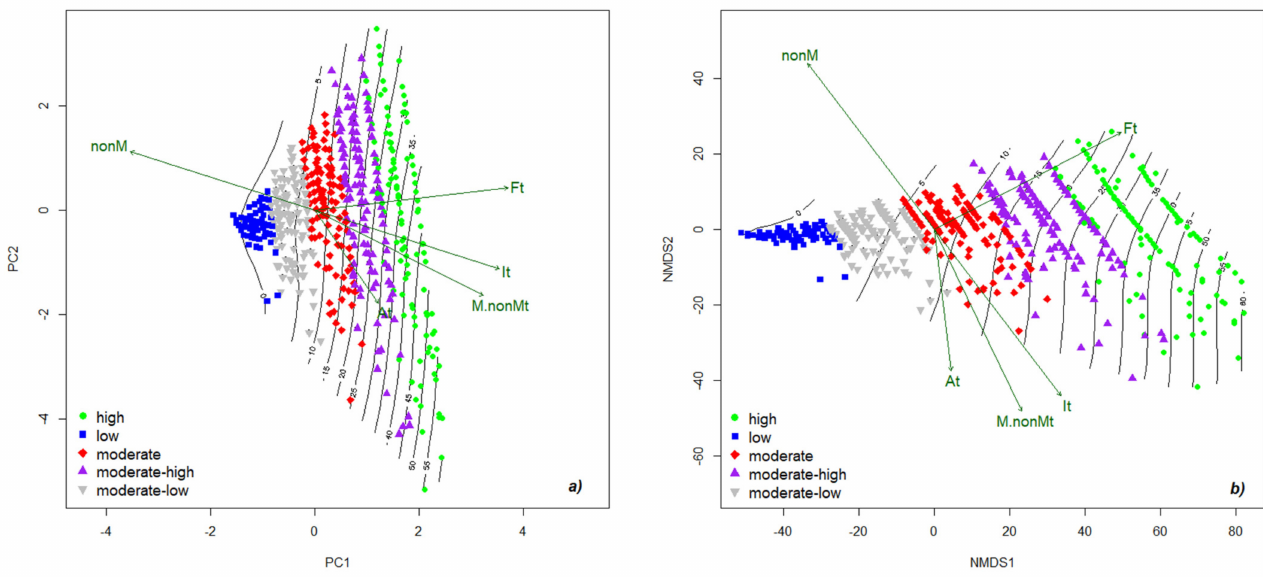
Figure 4. PCA ( a ) and NMDS ( b ) projection of the mycorrhizal pattern and their gradient in the roots of Festuca rubra . The five classes are based on the frequency of colonization classes: M1, low level (0–20%); M2, moderate–low level (21–40%); M3, moderate level (41–60%); M4, moderate– high level (61–80%); and M5, high level (81–100%). Legend: Ft—frequency of colonization; It— intensity of colonization; Arb—arbuscules abundance; nonM—non-mycorrhizal areas; M.nonMt— mycorrhizal/non-mycorrhizal area